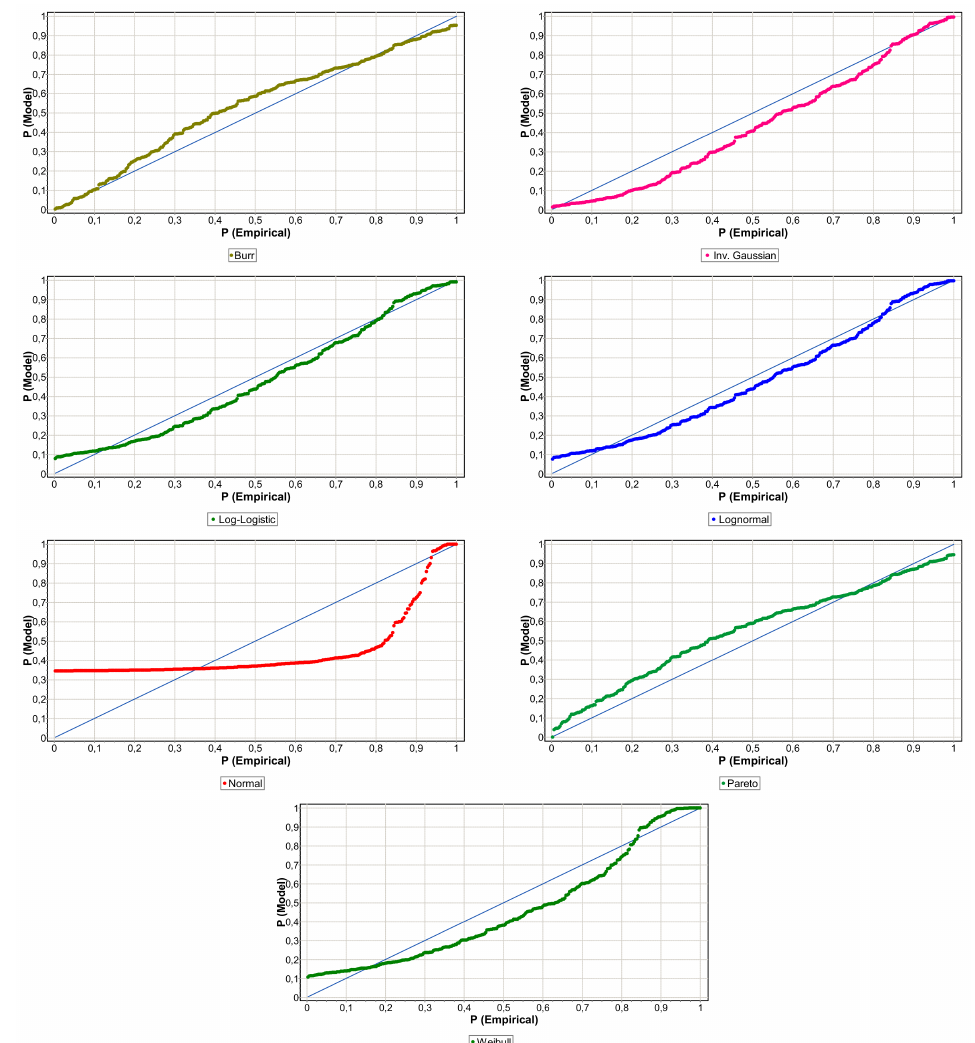
Figure 5. Non-clinical risk P-P plots of severity